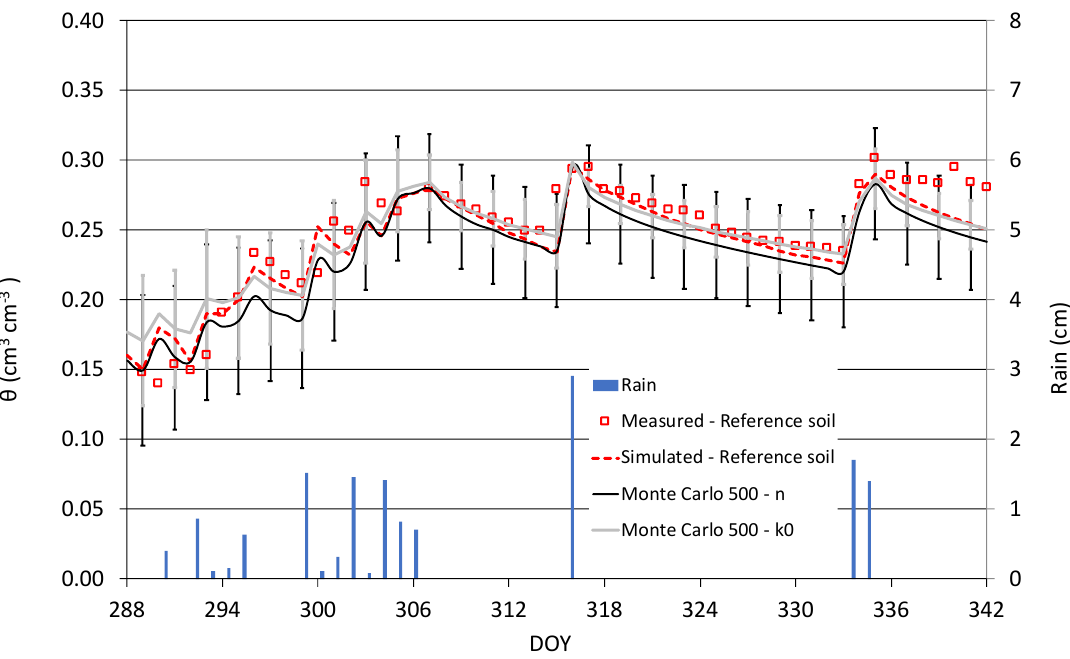
Figure 2. Soil water content measured and simulated (red squares and red dashed line) in the reference soil. Black and grey lines are the average soil water content applying 500 Monte Carlo runs of the n and k 0 parameters, respectively. Error bars represent the standard deviation of the two set of 500 Monte Carlo runs.